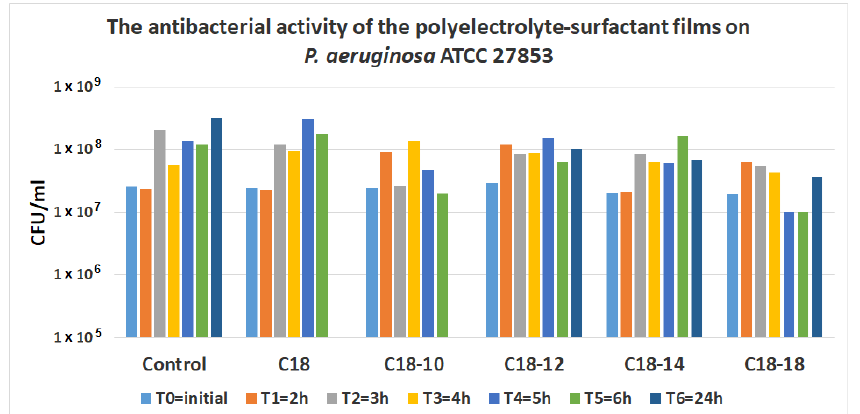
Figure 2. The antibacterial activity of the polyelectrolyte–surfactant films on P. aeruginosa ATCC 27853 at different times of contact (initial, 2, 3, 4, 5, 6, and 24 h): (control — clear glass, C18- (PAC 18 Na/PDADMAC) 20 , C18-10-(PAC 18 Na-C 10 TAB/PDAMAC) 20 , C18-12-(PAC 18 Na-C 12 TAB/ PDAMAC) 20 , C18-14-(PAC 18 Na-C 14 TAB/PDAMAC) 20 , and C18-18-(PAC 18 Na-C 18 TAB/PDAMAC) 20 ).